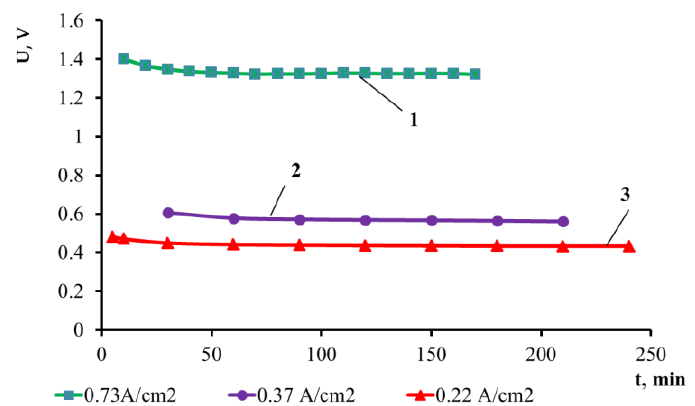
Figure 3. Time dependence of the electrodes’ voltage at the cathode current density: 1—0.73 A/cm 2 , 2—0.37 A/cm 2 , 3—0.22 A/cm 2 .